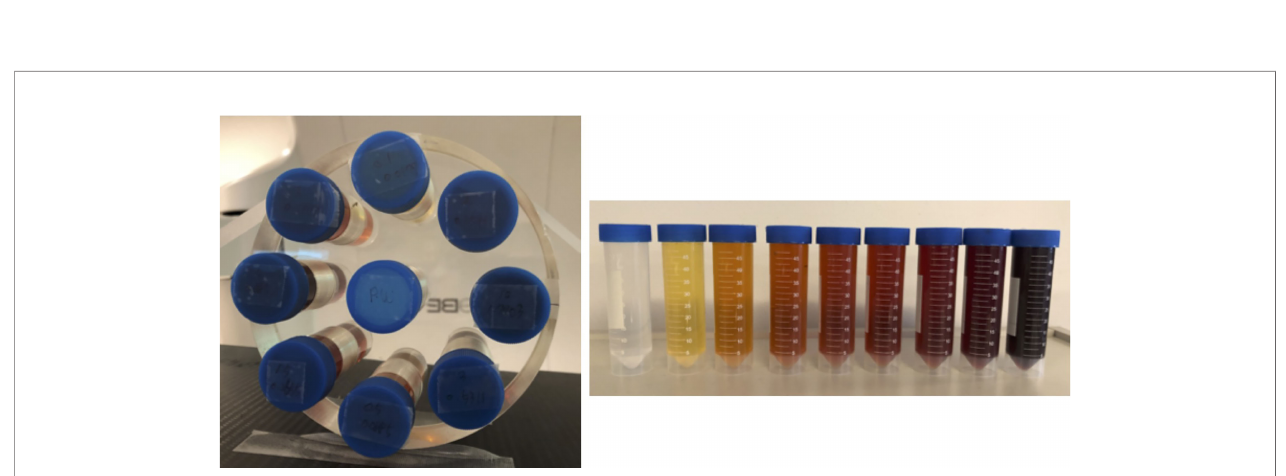
FIGURE 1 | Phantom used in this study with inserts of different concentrations of